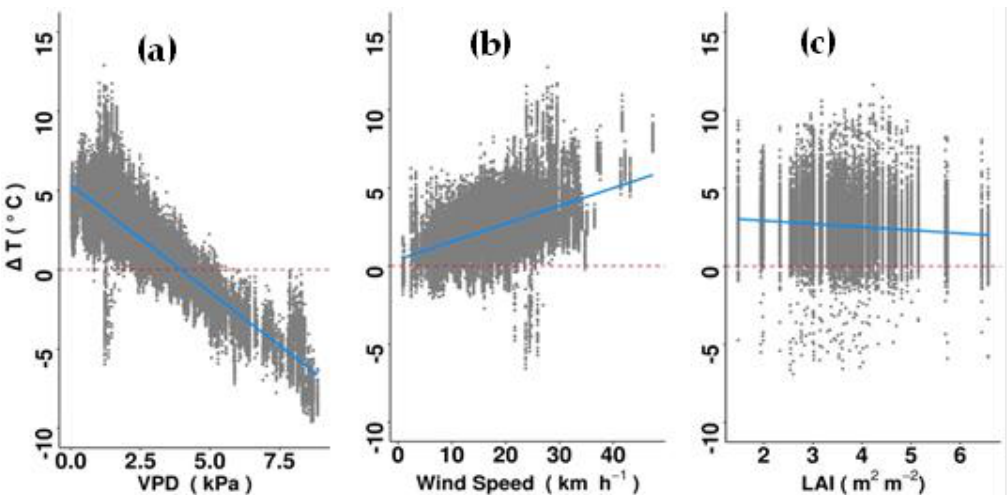
Figure 6. Relationship between Δ T and ( a ) vapor pressure deficit (VPD), ( b ) wind speed and ( c ) leaf area index (LAI) in the afternoon, using all recorded data from 96 individual trees over a three- month period. The dashed red lines indicate no difference between the sub-canopy and ambient air temperatures and soild blue lines correspond to regression slopes. There was a total of 127,822 data points. For detailed results of the lmer model see Supplementary Table S3.